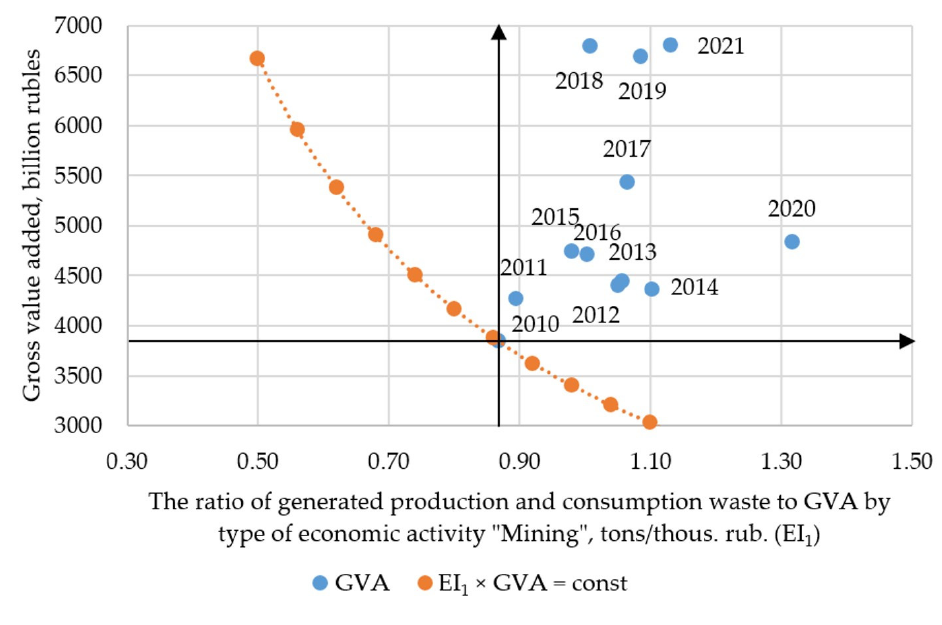
Figure 2. The color of environmental and economic development in terms of production and consumption waste generation by type of economic activity “Mining” in the Russian Federation for the period 2010–2021.